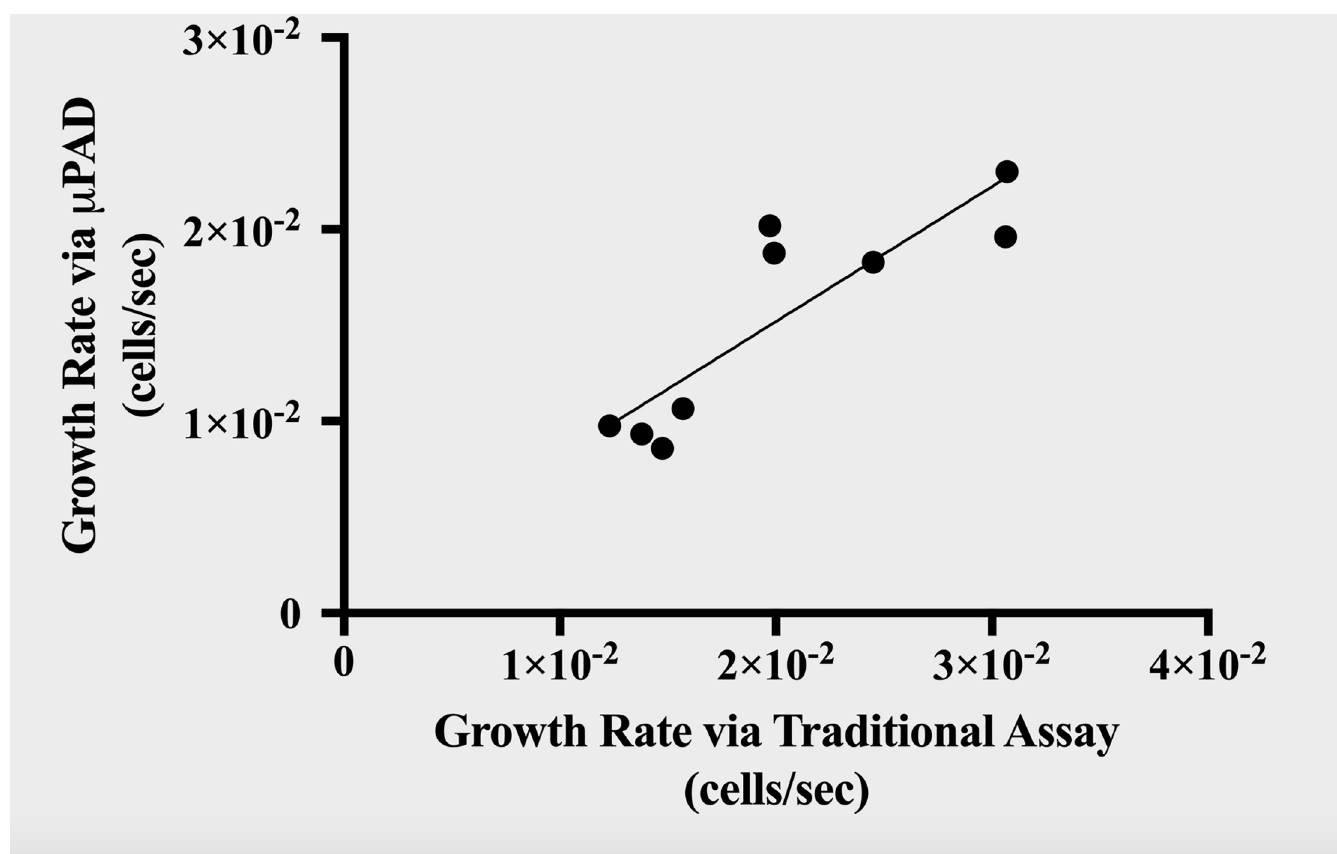
Fig 7. Comparison of growth rate measurements via traditional and μ PAD assays for E . coli sucrose gradient. The relationship between the E . coli growth rate (cells/ sec) measured by the traditional Petri dish method (x-axis) and the proposed μ PAD method (y-axis) can be modelled by the equation, y = .7027x + .0011. This model accounts for 75.56% of the variability in the data per R 2